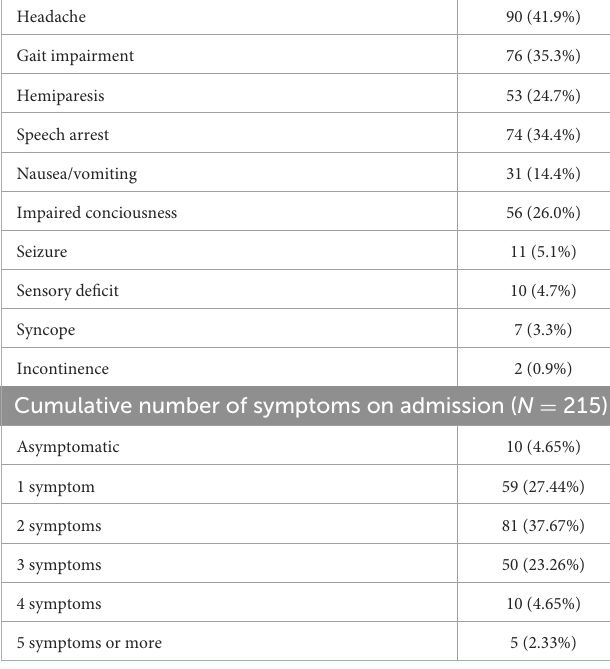
TABLE 2 Symptoms on admission of cSDH